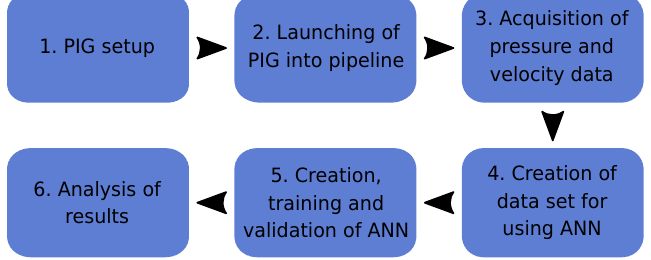
Figure 8. Flowchart of experimental procedure. Source: By